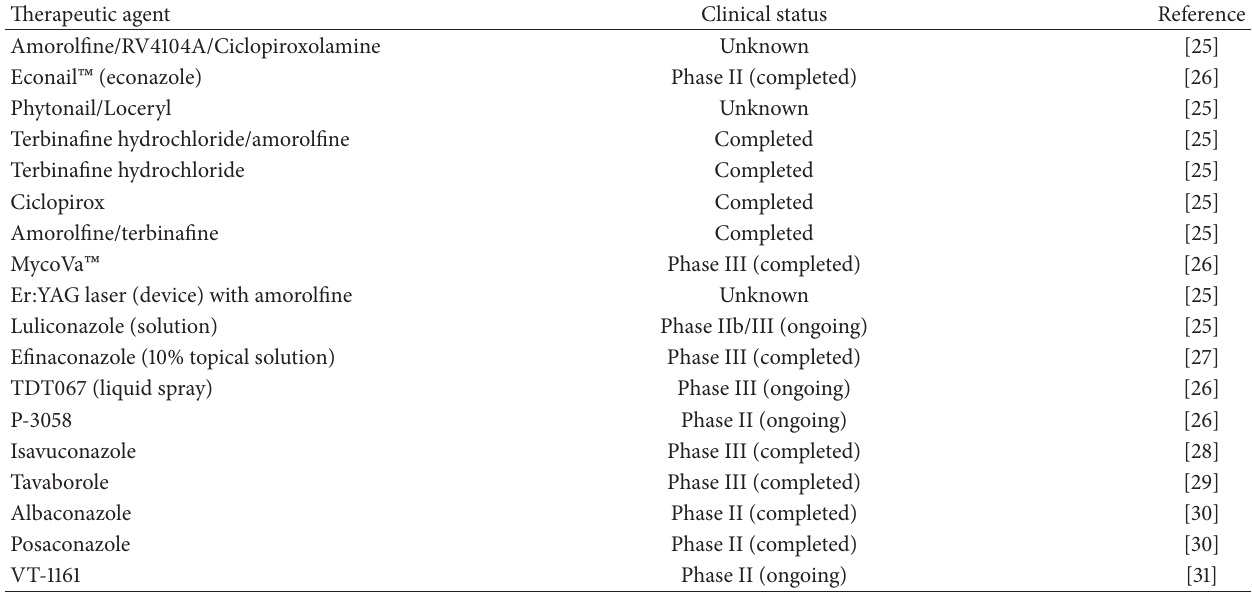
Table 4: Clinical status of antifungal drugs used in